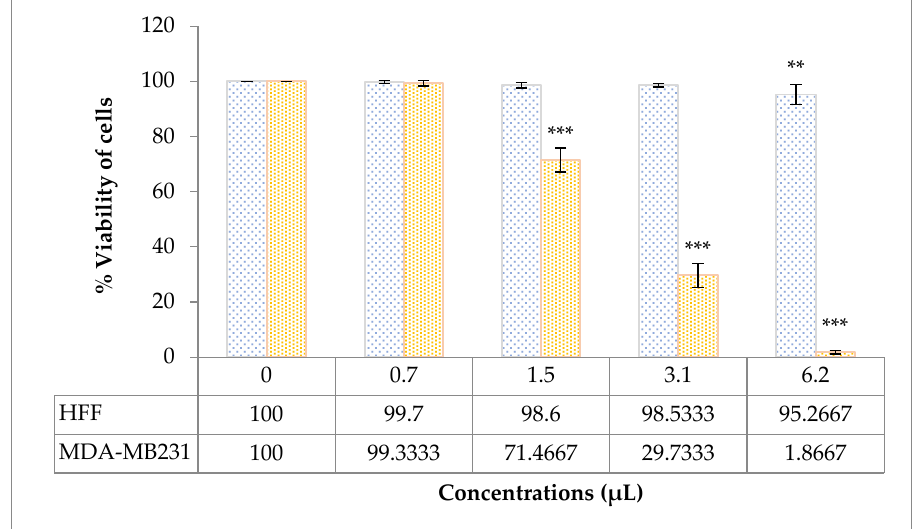
Figure 2. Effect of Heracleum persicum oil nanoemulsion (HAE-NE) on human fibroblasts foreskin (HFF) and human breast cancer cell (MDA-MB-231) viability. Values represent the mean ± standard deviation from three independent experiments. Symbols provided on bars indicated differences between groups—no symbol: p ≥ 0.05, **: p < 0.01 and ***: p < 0.001.